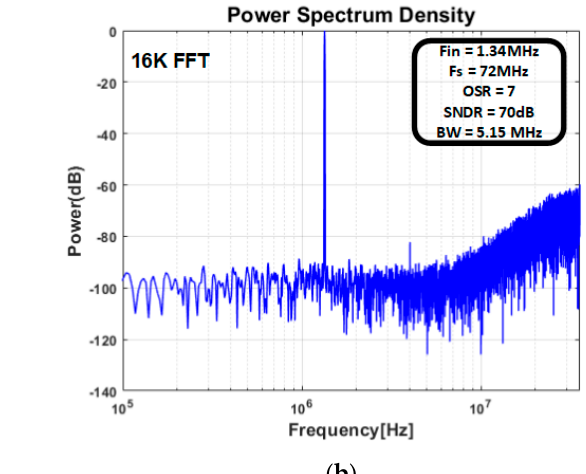
Figure 15. The measured SNDR versus input frequency. Figure 16. The power consumption breakdown of the proposed ADC. 5. Conclusions This work demonstrates a proposed ADC that was designed and fabricated using a 65 nm CMOS process. Using the PLNS-SAR ADC structure, it is possible to implement a high resolution without being subject to comparator design requirements. The inter-stage amplifier and integrator are implemented by a ring amplifier. Using the ring amplifier, the power consumption is reduced by 30% compared to the conventional PLNS-SAR ADC power consumption. Using the high-gain ring amplifier, noise leakage is minimized and